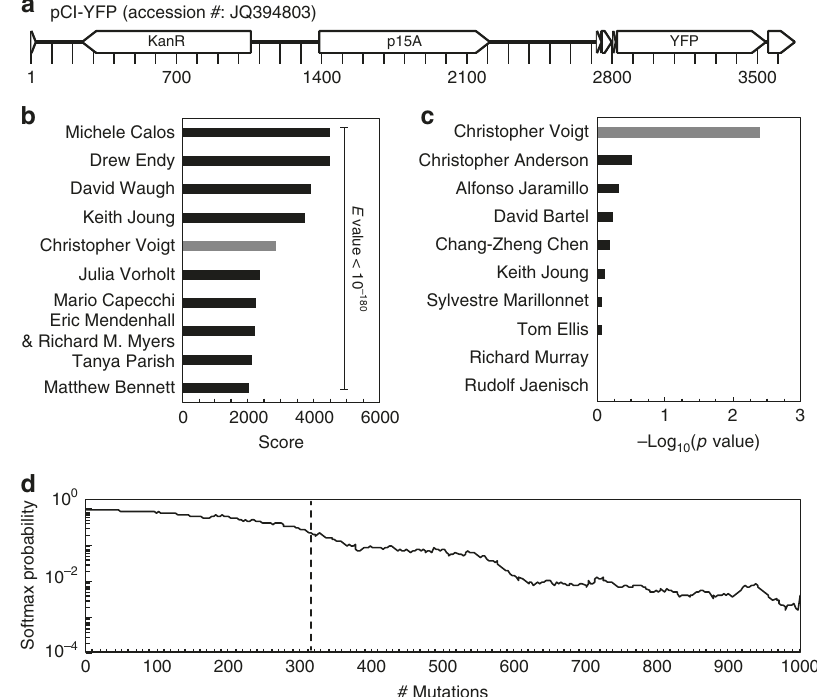
Fig. 3 Statistical analysis of neural network and BLAST results. a Plasmid map for pCI-YFP with labeled major genetic features shown. b BLAST score for pCI-YFP alignments to plasmid training set (depositing lab shown instead of plasmid name). c P values for pCI-YFP lab predictions calculated from activities. d Effect of point mutations on the Voigt lab softmax probability for pCI-YFP . The geometric mean of 30 trajectories of random mutations is shown, with the average number of mutations that cause an incorrect top prediction (dashed